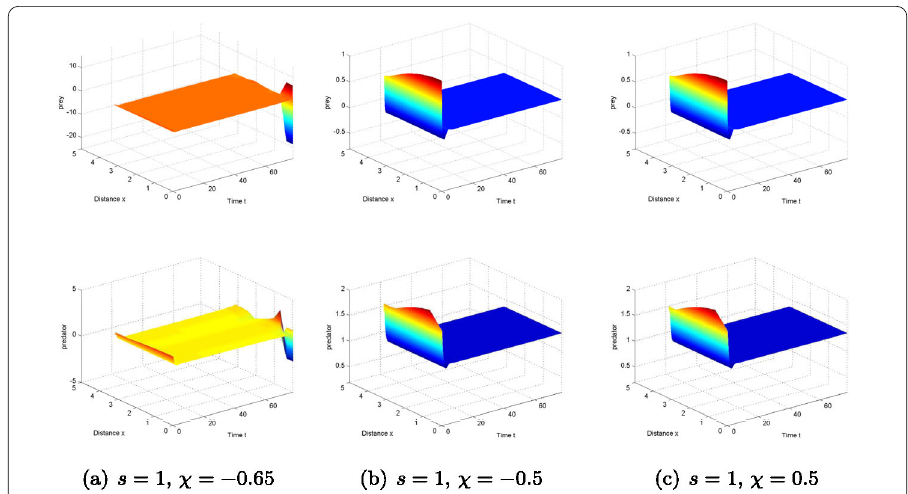
Figure 6 The positive equilibrium ( ¯ u , ¯ v ) ≈ (0.3445,1.3445) loses its stability when χ = –0.65 < max χ i , and maintains stability for χ = –0.5, 0.5 > max χ i